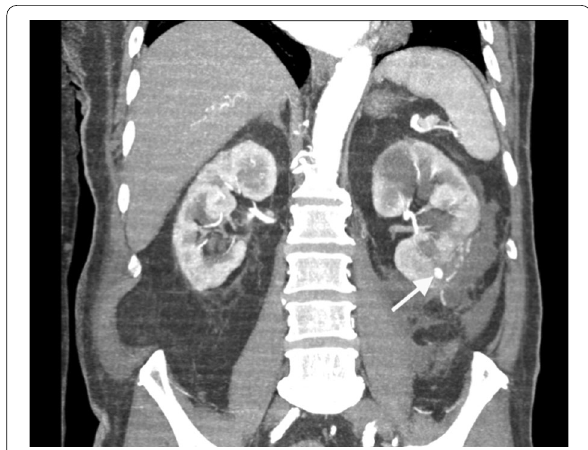
Fig. 1 Arterial phase CT image of a pseudoaneurysm (white arrow) post-laparoscopic partial nephrectomy of the lower pole of the left